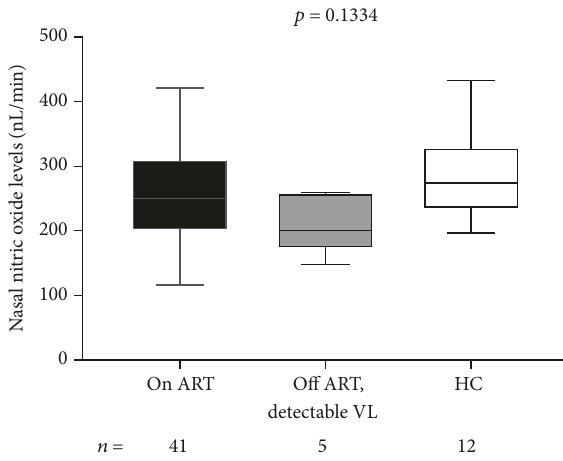
Figure 1: Nasal NO levels across the 3 groups of participants . Mean nasal NO levels in HIV-infected individuals with suppressed viral load on ART (black bar), HIV-infected individuals with detectable viral loads (VLs) off antiretroviral therapy (ART) (grey bar), and healthy controls (HC, white bar). The differences of mean nasal NO levels among groups did not reach statistical